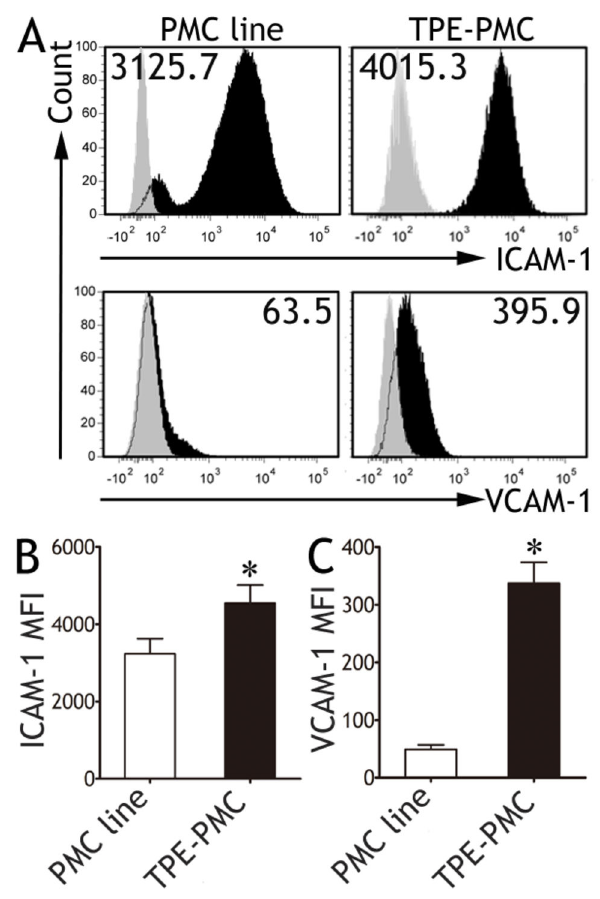
Figure 1. Expressions of intercellular adhesion molecule-1 (ICAM-1) and vascular cell adhesion molecule-1 (VCAM-1) on pleural mesothelial cells